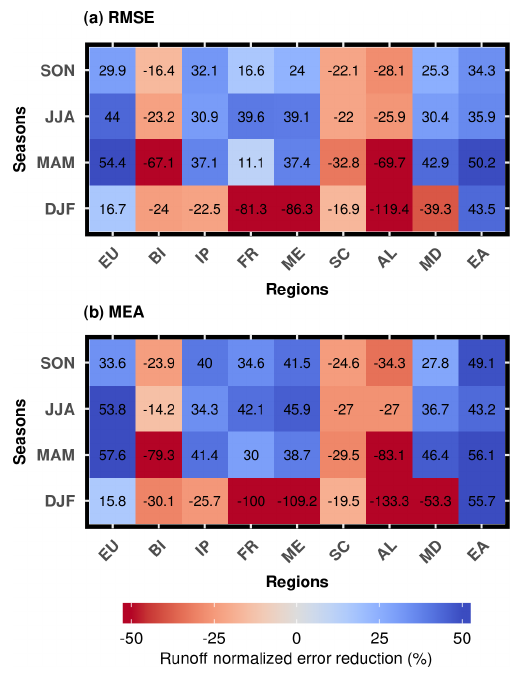
Figure 10. Normalized error reduction (NER) index of (a) RMSE and (b) MEA for runoff over different seasons and PRU- DENCE regions using CLM-OL and CLM-DA simulations over the years